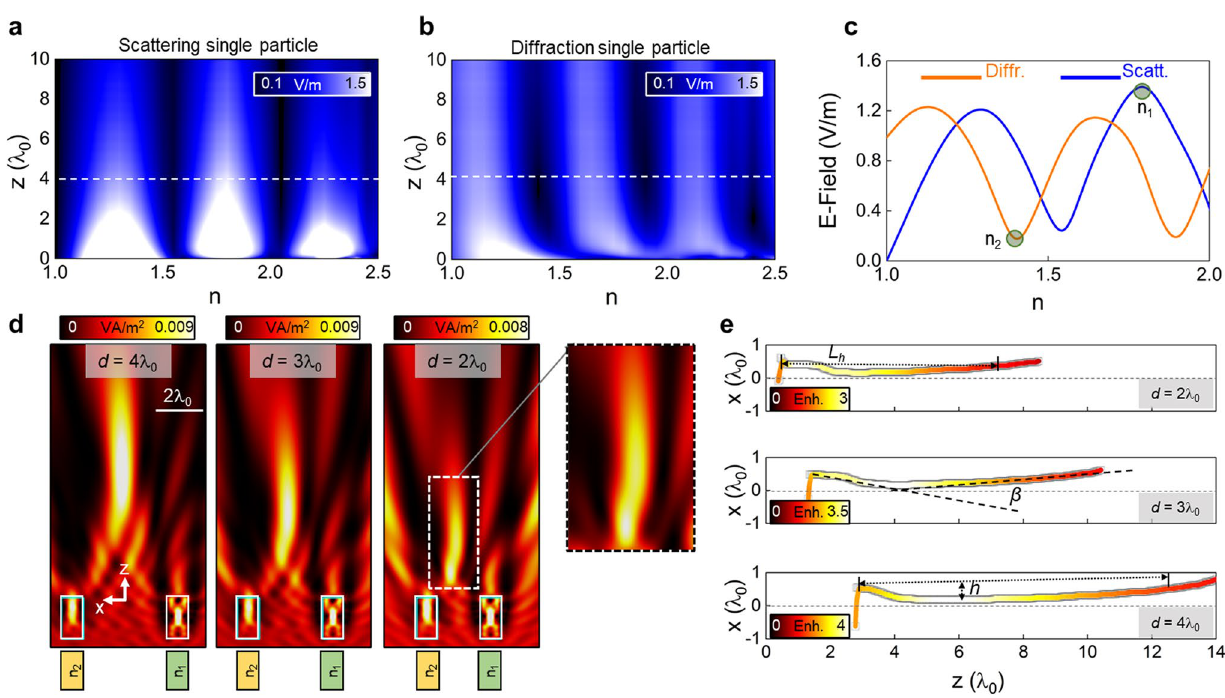
Figure 4. ( a , b ) Numerical results of the scattered and diffracted field distributions, respectively, along the propagation z -axis generated by a single dielectric particle with lateral dimension L x = λ 0 and L z = 2 λ 0 with variable refractive index, n , immersed in free-space. ( c ) Scattered (blue line) and diffracted (orange line) extracted from the dashed white lines of panels a and b, respectively, at z = 4 λ 0 . ( d ) Numerical results of the power distribution on the xz plane of a dual-dielectric structure with both dielectric particles having the same lateral dimensions L x1,2 = λ 0 and L z1,2 = 2 λ 0 and refractive index values of n 1 = 1.8 and n 2 = 1.4 to generate maximum scattering and minimum diffraction, respectively (see panel c ). The distance d between the dielectrics is d = 4 λ 0 (left), d = 3 λ 0 (middle) and d = 2 λ 0 (right). The inset in this latter panel corresponds to a zoom-in-image of the field distribution for the case with d = 2 λ 0 . ( e ) Numerical results of the ( x, z ) positions of the maximum power enhancement for the dual-dielectric structures with d = 4 λ 0 (bottom), d = 3 λ 0 (middle) and d = 2 λ 0